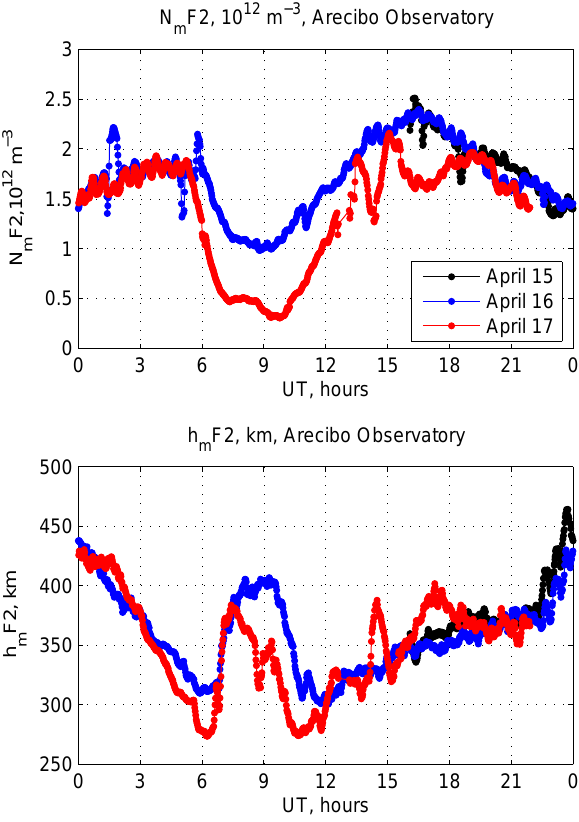
Fig. 11. Electron density at the peak of the F-layer Nm F2 (top) and the height of the F-layer hm F2 (bottom) at Arecibo for 15–17 April 2002.